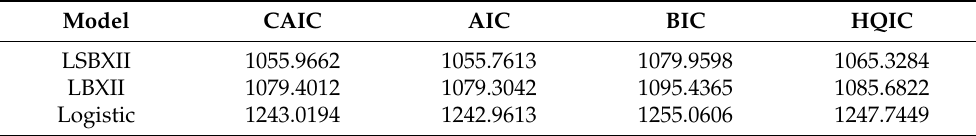
Table 7. Adequacy measures for three regressions.